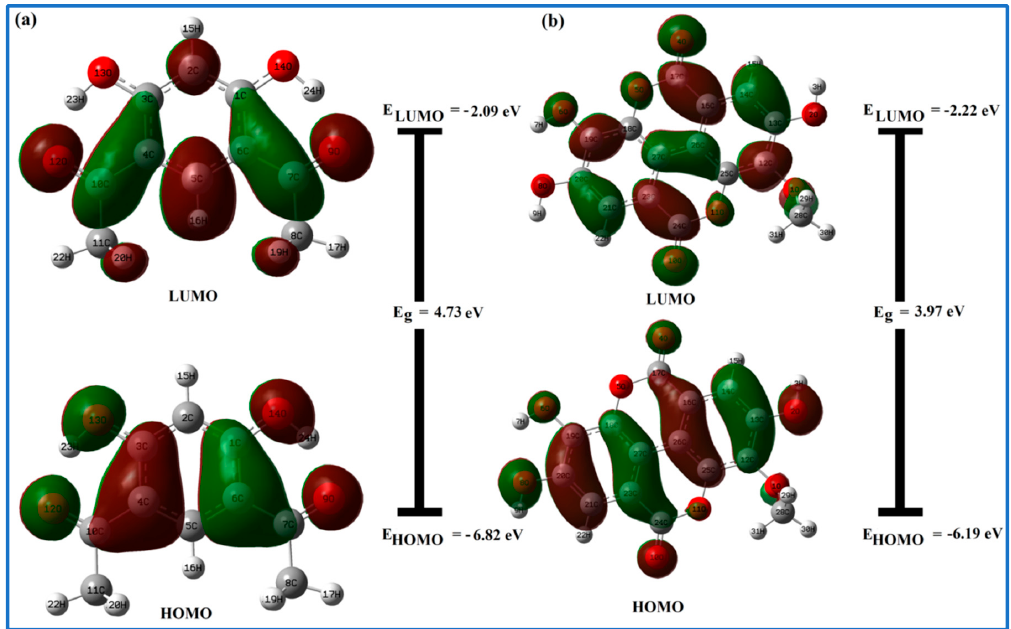
Figure 6. Energy levels, gaps and localization distribution of HOMO and LUMO (frontier molecular orbitals) of the ( a ) and ( b ) for compounds 1 and 2 , (energies are given in eV). Table 3. UV/Vis spectral characteristic of compounds 1 and 2 in the solution